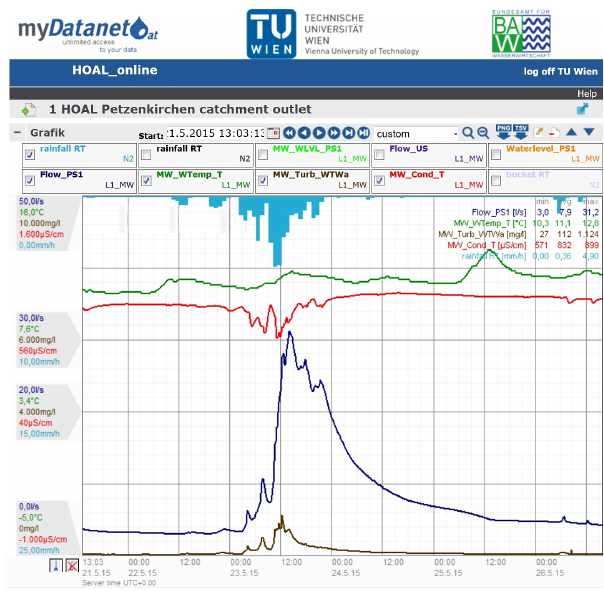
Figure 9. Screen shot of web-based real-time monitoring of the data collected in the